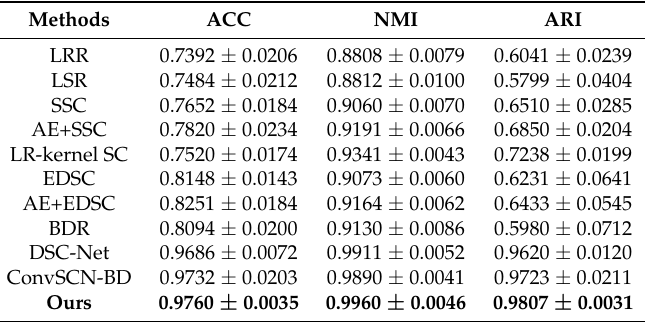
Table 4. Clustering performance of different algorithms on the PIE